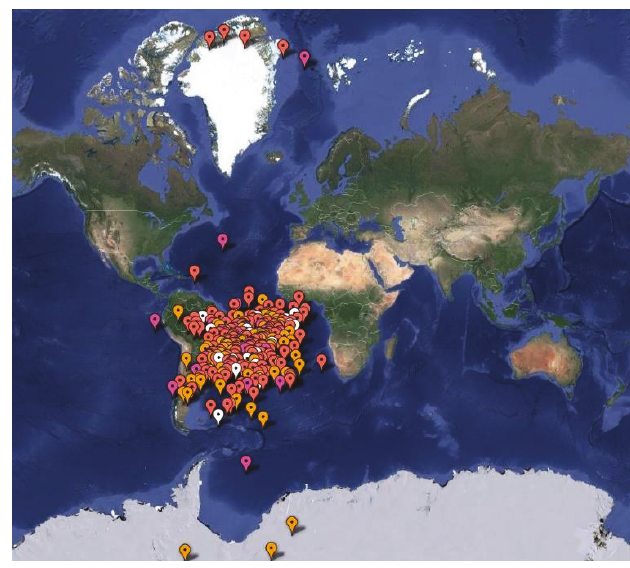
Figure 8: World map error distribution by error